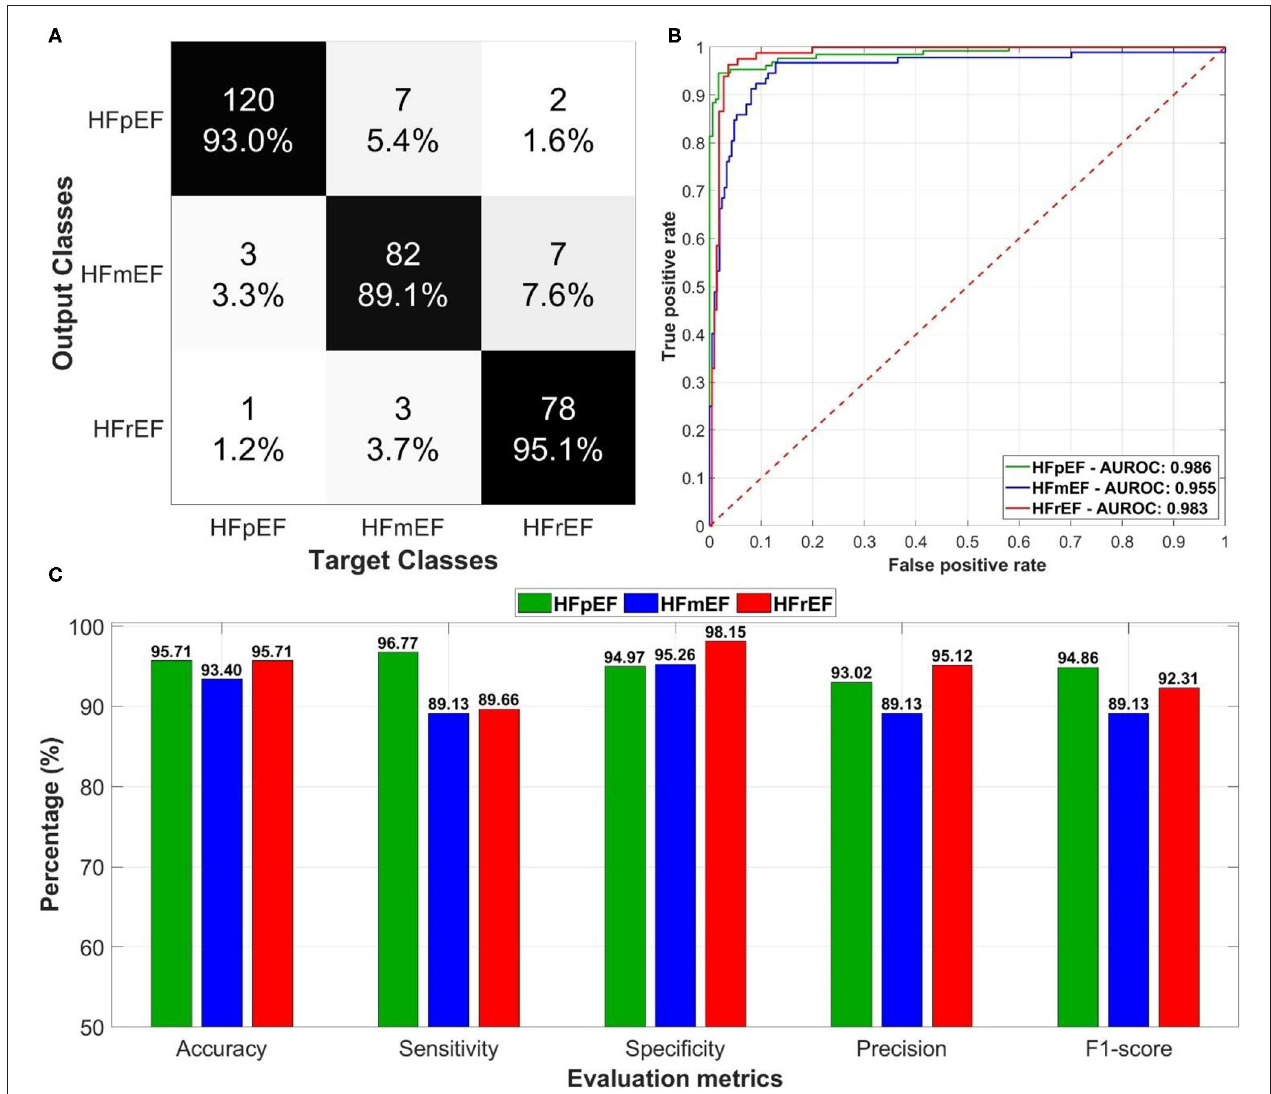
FIGURE 5 | The overall performance of the deep learning-based classification model in predicting left ventricular ejection fraction (LVEF) categories in heart failure patients: (A) confusion matrix of the predictions for the output and target classes, (B) receiver operating characteristics (ROC) curves for each LVEF category with the corresponding area under the ROC curves, and (C) evaluation metrics including accuracy, sensitivity, specificity, precision, and